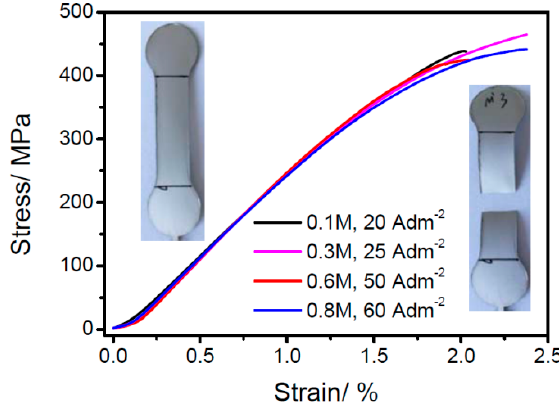
Figure 11. Representative stress–strain curves of Fe–Ni alloy foils electrodeposited from chloride baths that contained 0.1, 0.3, 0.6, and 0.8 M Ni 2+ ion. The insets are views of a Fe–Ni alloy foil before and after tensile test.